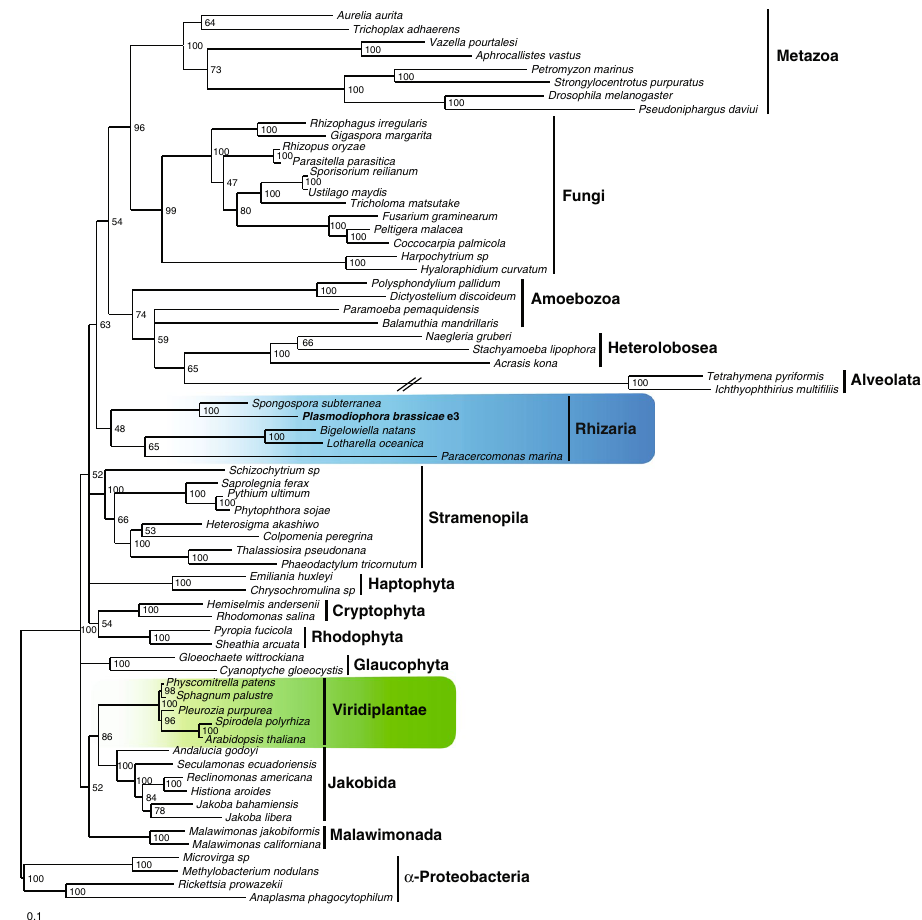
Figure 5. Maximum likelihood tree inferred from mitochondrial-encoded proteins. The tree was constructed from a concatenated alignment of 12 mitochondrial protein sequences from 67 organisms (63 from major eukaryotic groups and 4 α -protebacteria used as outgroup species). The super-matrix was analyzed with RAxML 8.2.11 60 using GAMMA and substitution models specified for each partition. For details, see Supplementary Table S15. Rapid bootstrap analysis was done with 250 iterations. Branches with support values < 45 were collapsed. The scale bar shows the inferred number of amino acid substitutions per site. The long branch was reduced to 50% of its original length, indicated by a crossed double